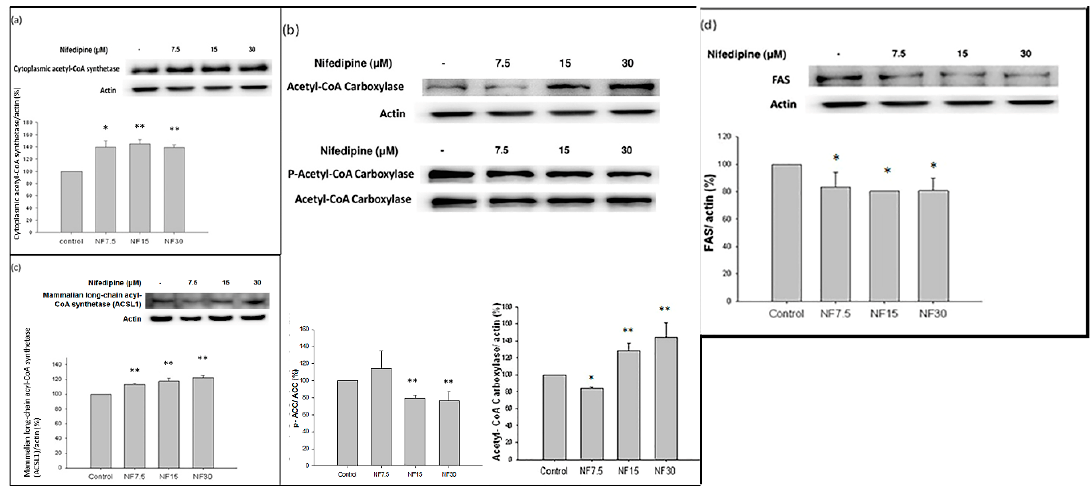
Figure 4. Nifedipine stimulated de novo lipogenesis-1 in 48 h: ( a ) the ACS ( p < 0.05 by nifedipine 7.5 µM; p < 0.01 by 15 and 30 µM); ( b ) the ACC 128.5% and 144.4% at doses 15 and 30 µM, compared to the control ( p < 0.01), and p-ACC/ACC 81.5% and 74.1% at doses 15 and 30 µM, to the control ( p < 0.01); ( c ) the ACSL1 showed increased expression of 116.7%, 120%, and 126.7% at doses 7.5, 15, and 30 µM respectively ( p < 0.01); and ( d ) FAS showed decreased expression of 83.7%, 79.1%, and 81.4% at doses 7.5, 15, and 30 µM respectively ( p < 0.05). p -values ≤ 0.05 (marked as *) were considered statistically significant. In addition, p -values ≤ 0.01 are marked as **.